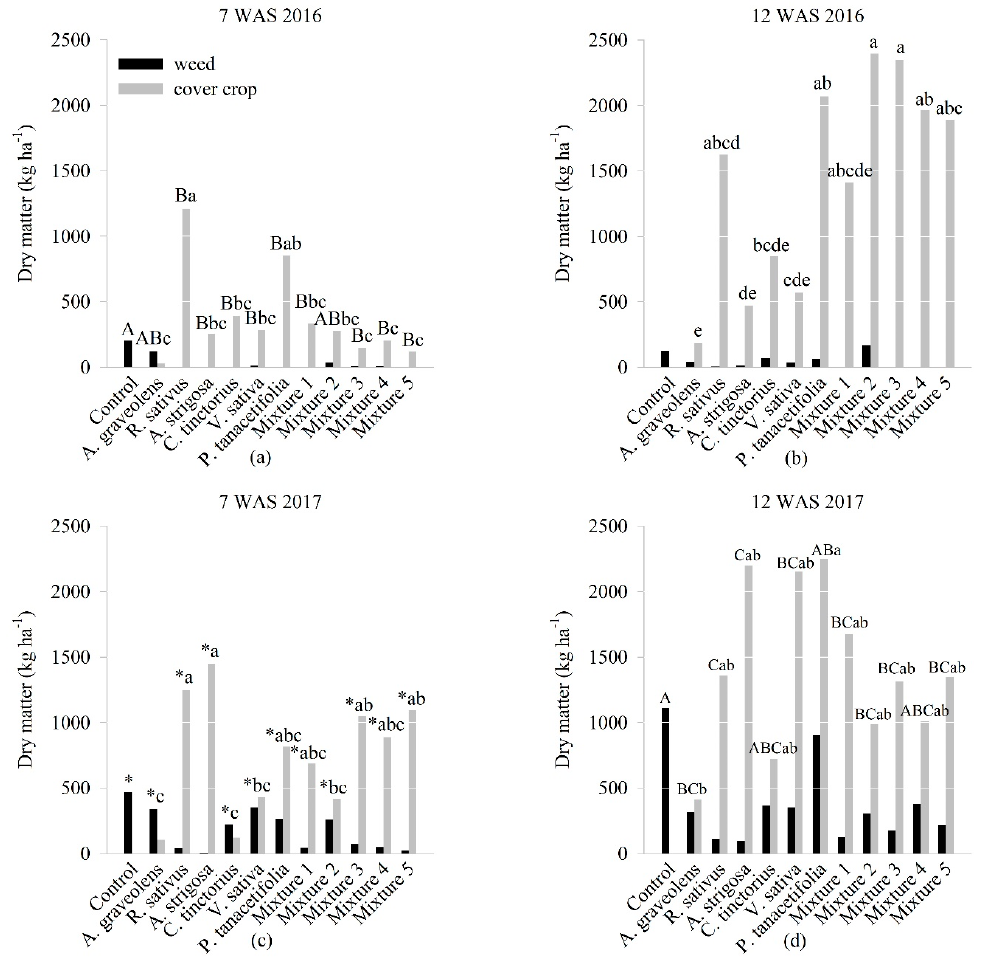
Figure 3. Cover crop (grey) and weed (black) aboveground dry matter in kg ha -1 for the six single sown and five cover crop mixtures 7 weeks after sowing (WAS) in 2016 ( a ) / 2017 ( c ) and 12 WAS in 2016 ( b ) / 2017 ( d ). Different small letters within one graph show significant differences